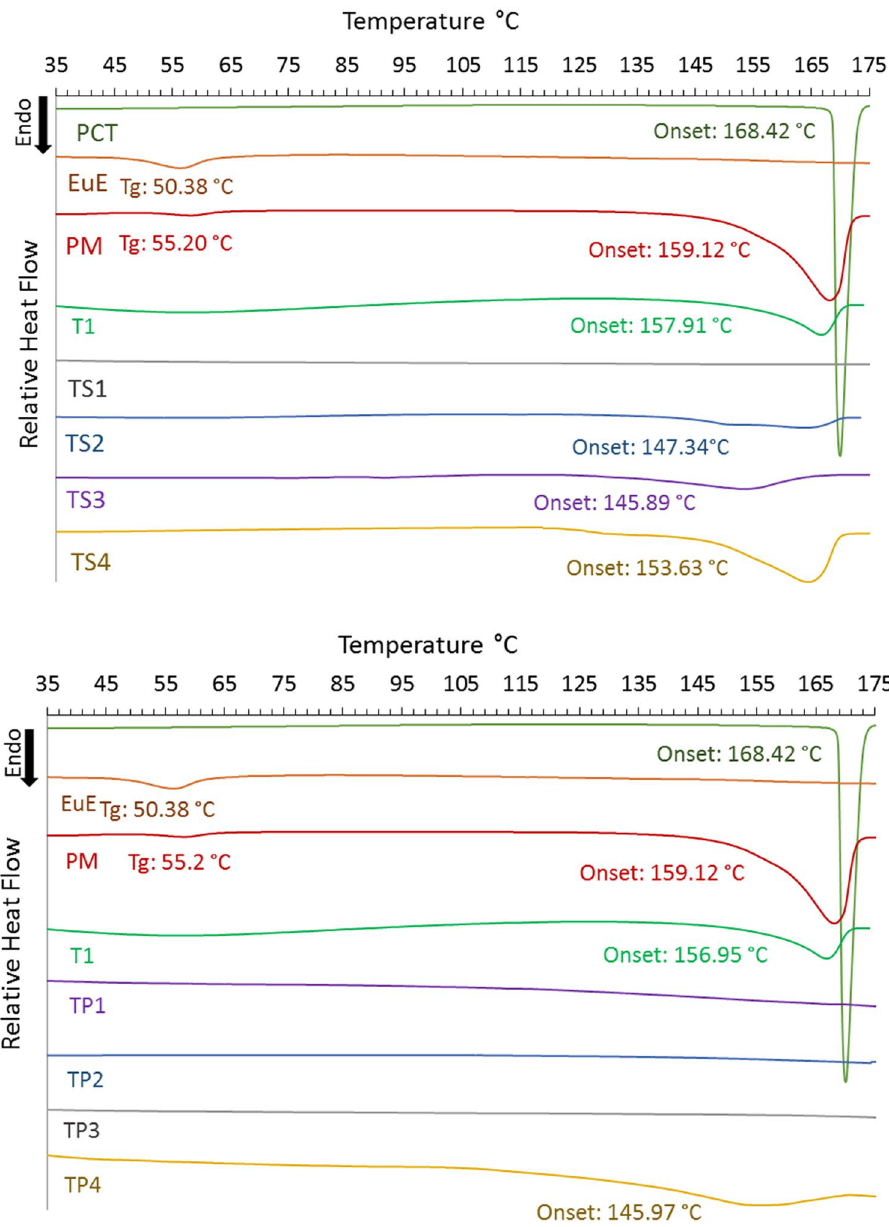
Figure 4. Thermograms of PCT, EUE, Physical mixture (PM), T1, and TS trials and showing peaks onsets and detected T g